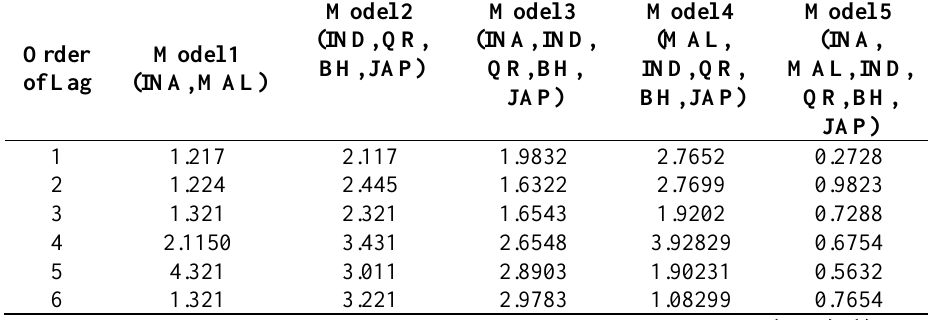
Table 4 ARDL- F Statistic For Testing Existence of